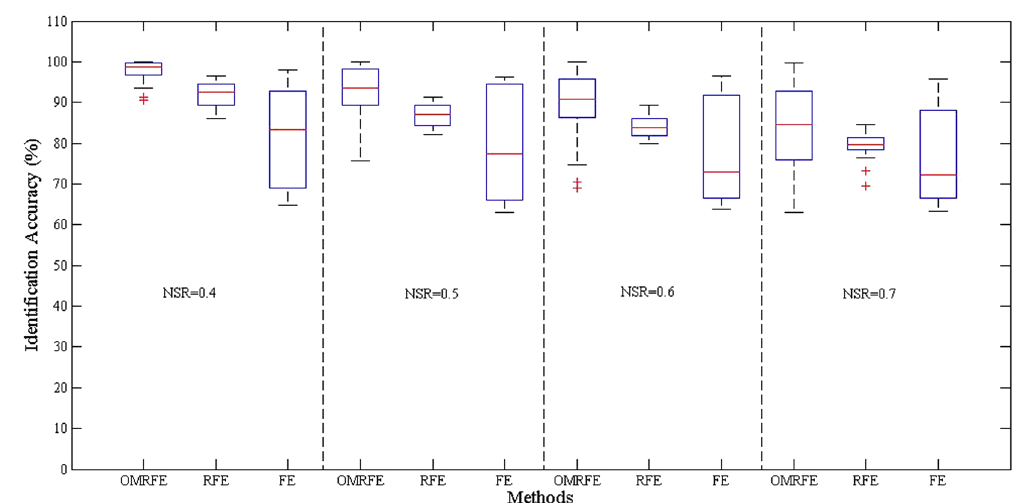
Figure 4. The identification accuracies of OMRFE, RFE and FE, where FE is the feature extraction method with L 2 -norm, RFE is the robust feature extraction method with L 2,1 -norm, and OMRFE is the robust feature extraction method with L 2,1 -norm and an optimal mean removed. NSR is denoted as the noise-to-signal